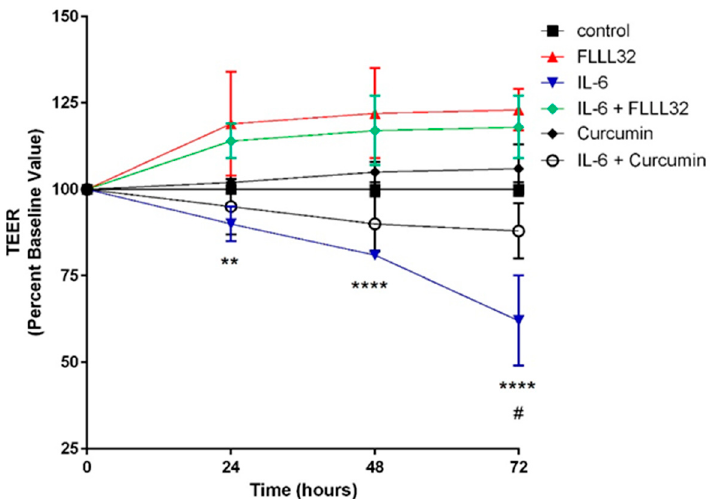
Figure 2. (Reprinted with permission from Dove Medical Press, Ltd.). Effect of FLLL32 and curcumin on IL ‐ 6 ‐ induced reduction of TEER in T84 monolayer. TEER value of T84 monolayers incubated with cell culture medium for 0–72 h in the presence of IL ‐ 6 (10 ng/mL) with FLLL32 (50 μ M), curcumin (50